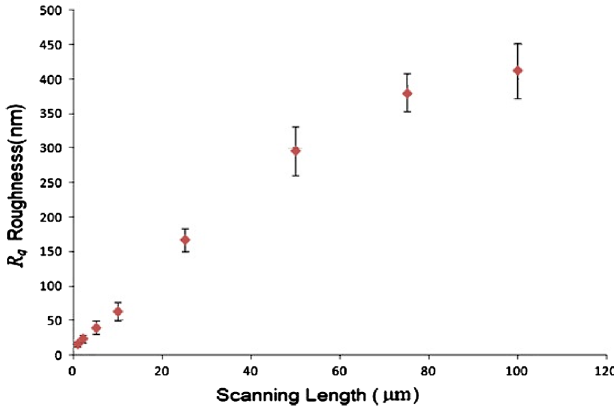
FIG. 5. R q as a function of AFM scan length for Nb after 100 (cid:1) m removal by BCP, average of three samples.